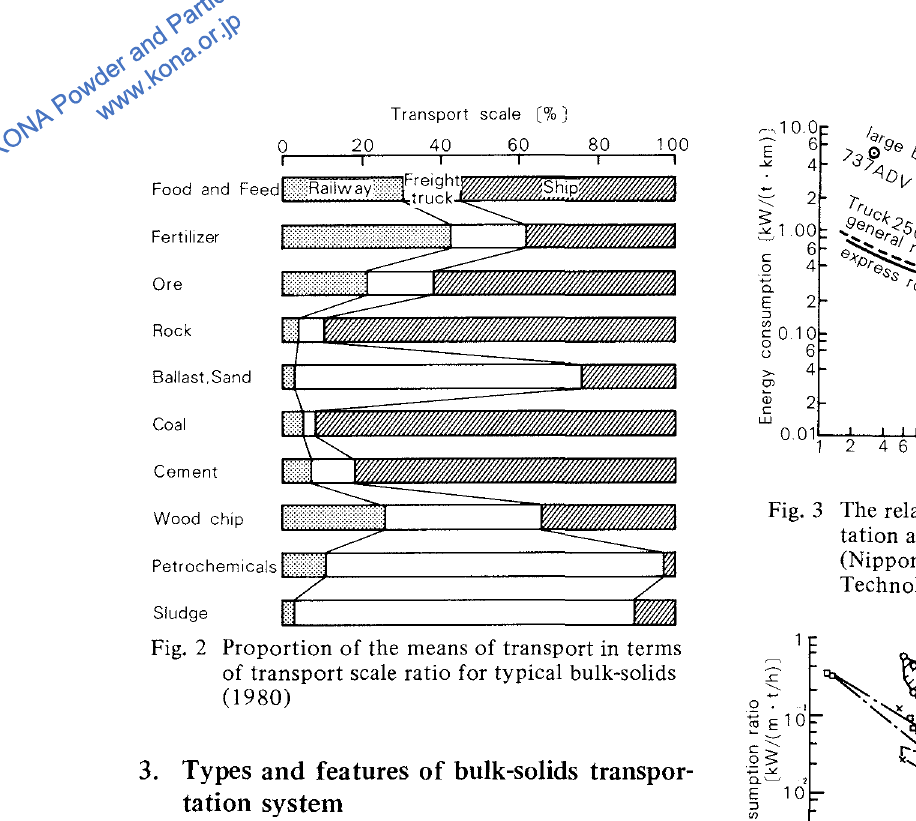
Fig. 2 Proportion of the means of transport in terms of transport scale ratio for typical bulk-solids (1980)